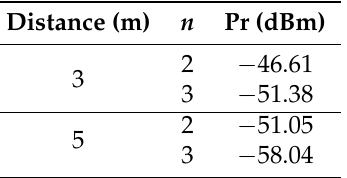
Table 2. Sensitivity of the wake up radio.